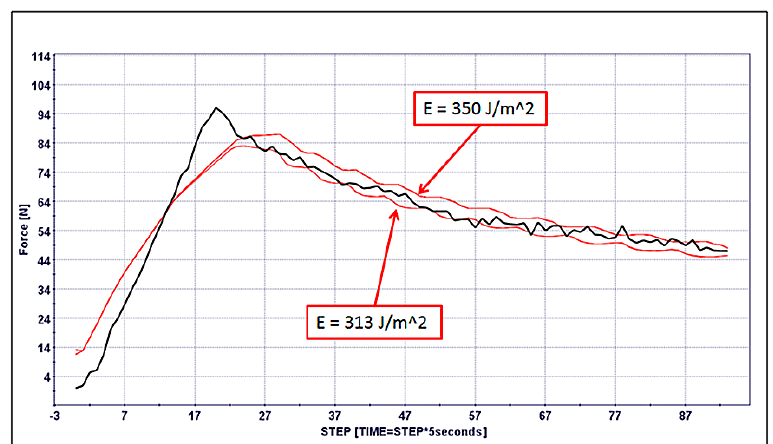
Figure 14. Comparison of the effect of the delamination energy G I on the performances of the best designs. Black curve reports the experimental data of the specimen 3, while red ones are the numerical results with the two different values of energy.